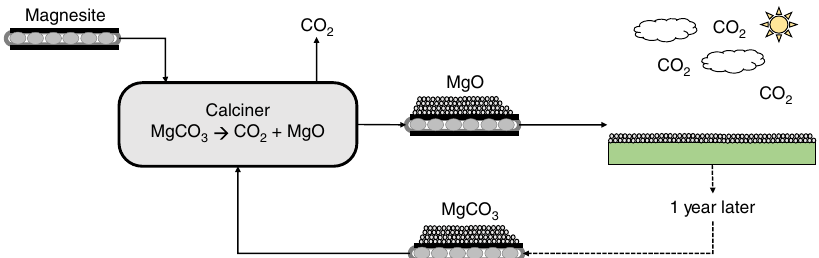
Fig. 1 Simpli fi ed schematic of the MgO looping process. The initial magnesite feedstock is fed into the calciner where the mineral is heated to produce CO 2 and MgO. The produced MgO is then transported to land plots where it is deposited and allowed to carbonate over a year. The weathered material is then recollected, primarily in the form of magnesium carbonate, and transported back to the calciner. Here, the material is fed to the calciner with additional magnesite feedstock to make up for environmental losses from the previous cycle. In the calciner, the material is once again heated to produce CO 2 and MgO. The process is